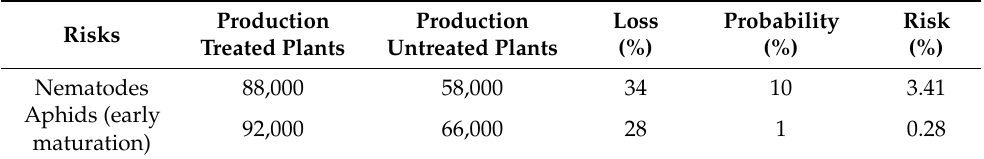
Table 4. Risk due to nematodes and